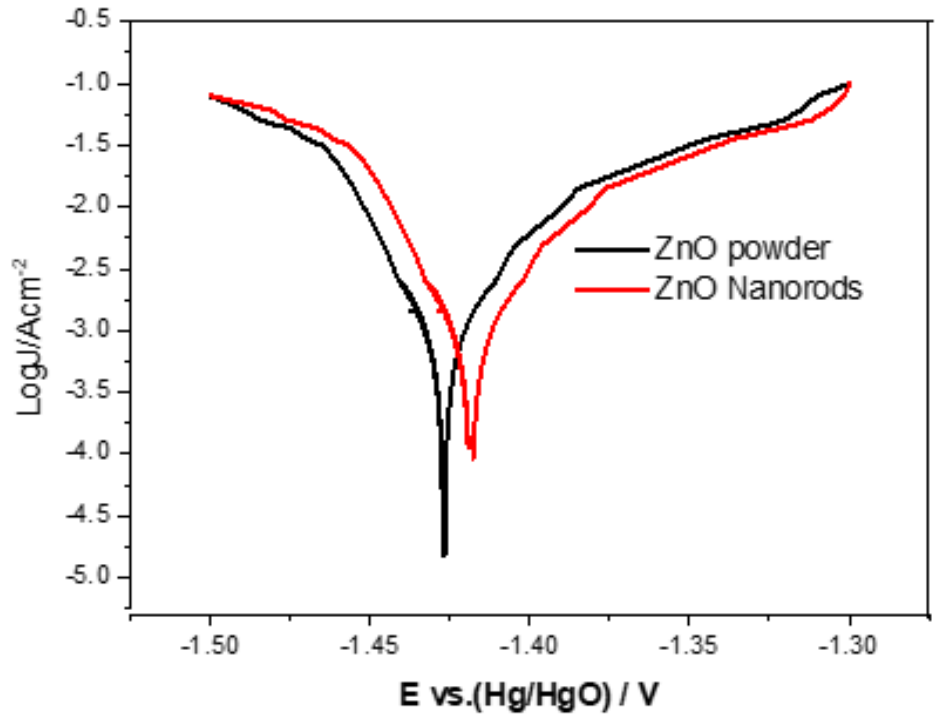
Figure 10. Tafel curves for zinc electrodes with ZnO powder and ZnO nanorods. Table 3. The data for the Tafel curves for zinc electrodes with ZnO powder and ZnO nanorods. Samples